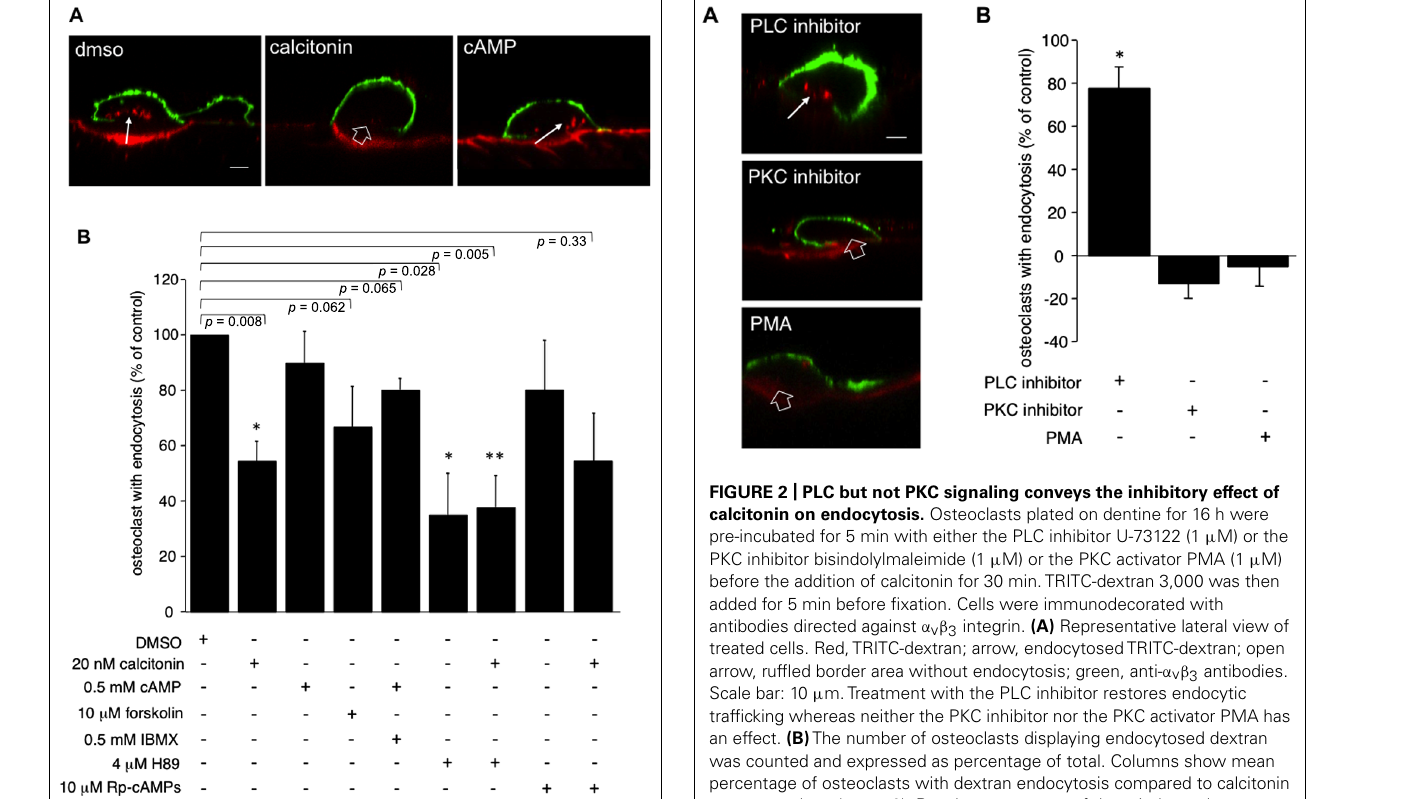
of the PLC inhibitor U-73122 before addition of calcitonin.